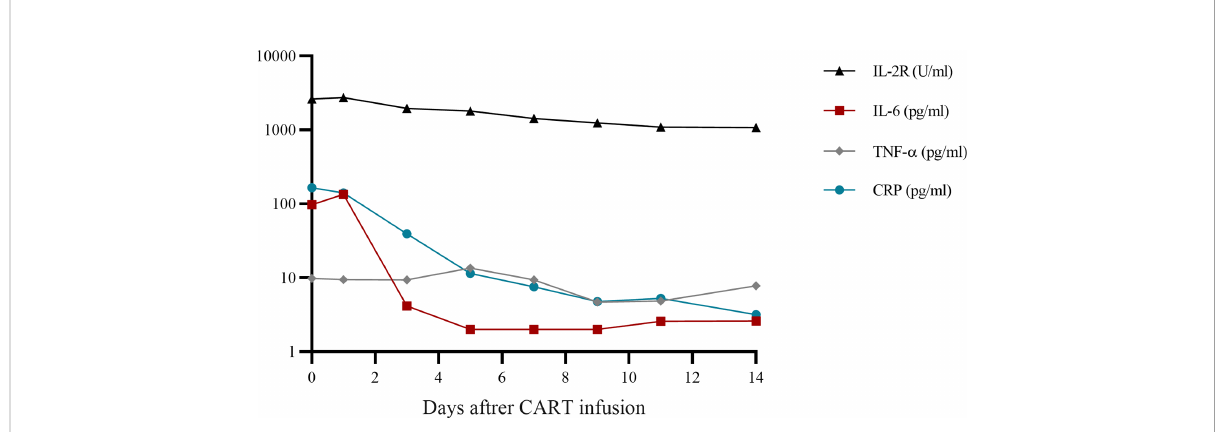
FIGURE 1 Cytokine monitoring after CART infusion. CART, chimeric antigen receptor T-cell; IL, interleukin; TNF, tumor necrosis factor; CRP, C-reactive